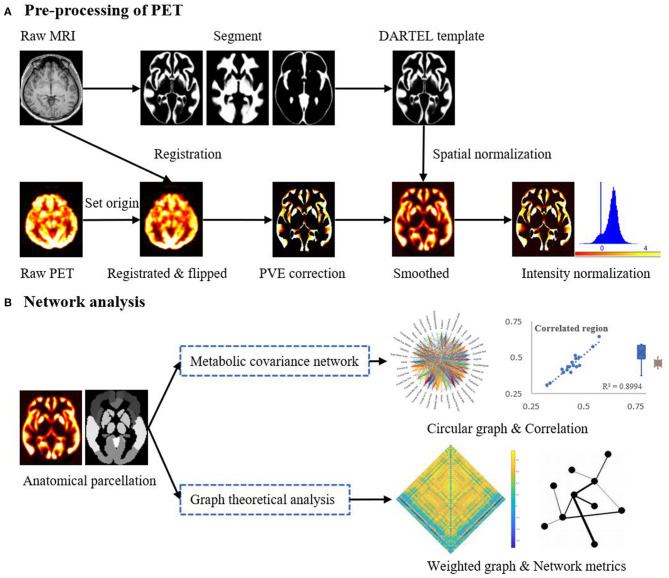
Schematic representation of the steps in (A) the pre-processing of the PET imaging data and (B) mapping of metabolic covariance networks. The topological properties of metabolic covariance networks were compared using graph-theoretical measurements between epileptic and healthy individuals. DARTEL, diffeomorphic anatomical registration through exponentiated lie algebra; MRI, magnetic resonance imaging; PET, positron emission tomography; PVE, partial volume effect.